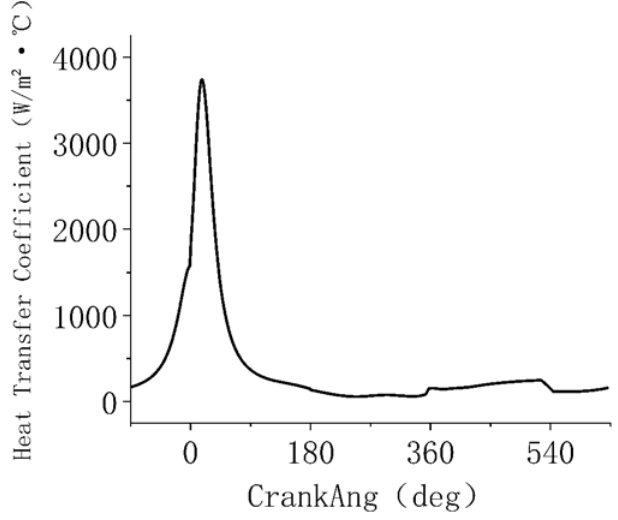
Fig. 7. Heat transfer coef fi cient variation curve with crankshaft rotation angle.